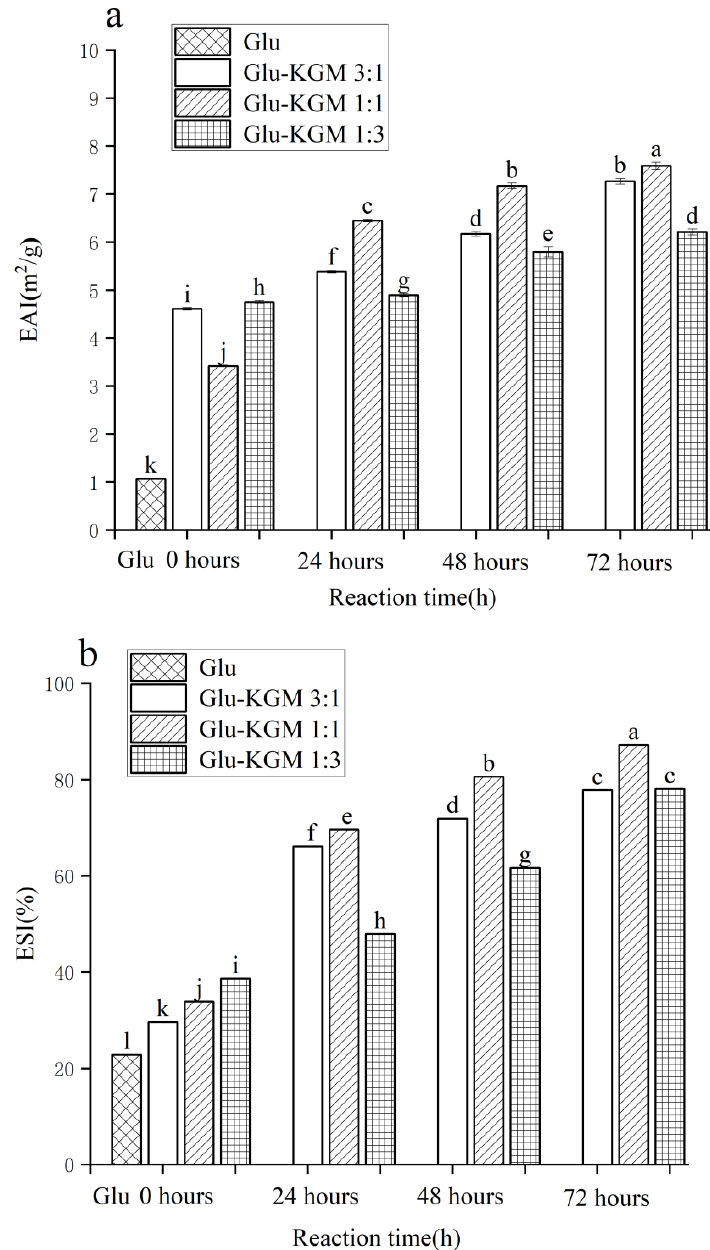
Figure 9. Emulsifying activity and emulsifying stability of gluten, mixtures, and conjugates, respec- tively. ( a ) Emulsifying activity of gluten, mixtures, and conjugates, respectively. ( b ) Emulsifying stability of gluten, mixtures, and conjugates, respectively. The results with different letters were significantly different ( p < 0.05).